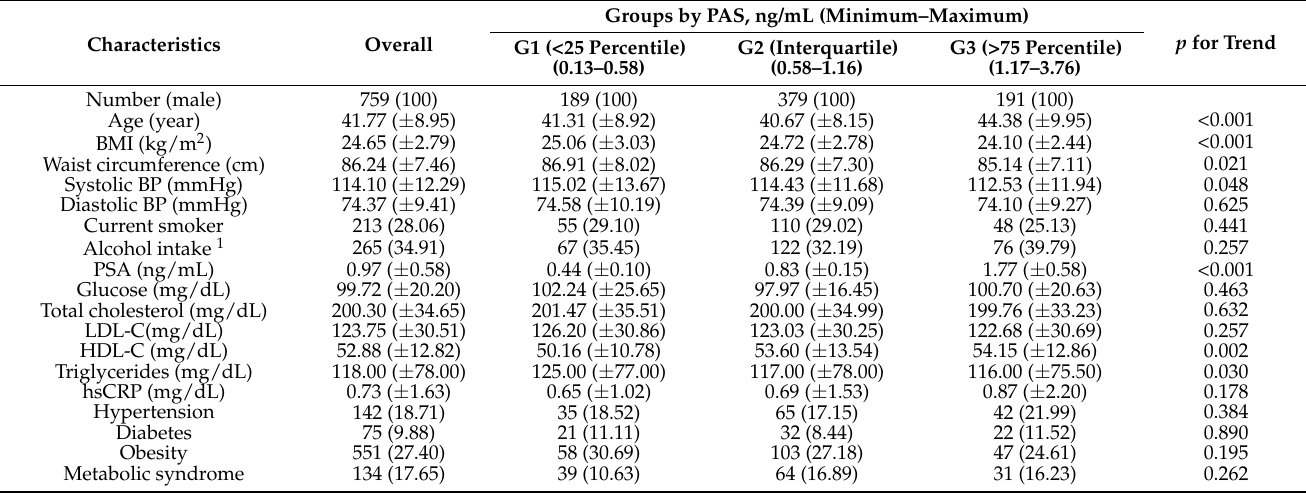
Table 1. Mean values (standard deviation) and the number (proportion) of baseline characteristics of the study participants by PSA.